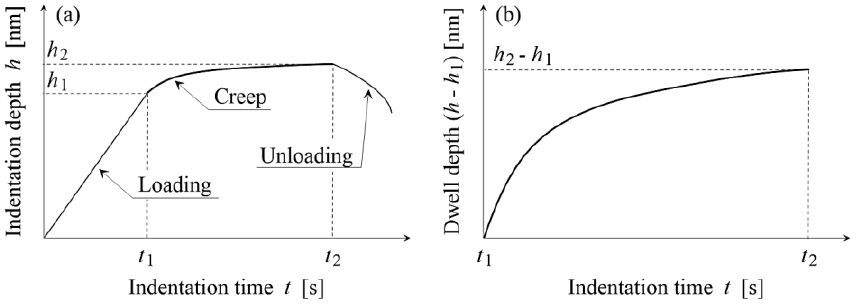
Figure 5. ( a ) Indentation curve including loading, creep, and unloading and ( b ) extracted creep phase only.